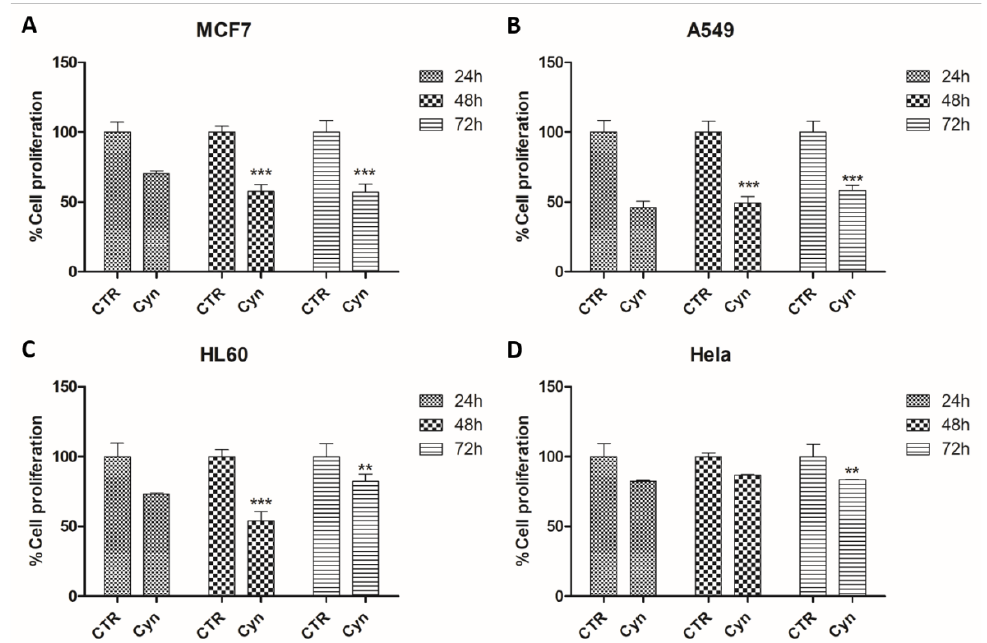
Figure 4. E ff ects of cinnamyl cinnamate treatment on cell proliferation of ( A ) MCF7, ( B ) A549, ( C ) HL60, and ( D ) Hela malignant cells. 500 cells were plated, in triplicate, in 384-well plates and treated with cinnamyl cinnamate at concentration of 10 µ M for 24, 48 and 72 h; cells treated with DMSO were used as control. Cell proliferation was measured performing a cell titer assay and expressed as a percentage of control ( ** p < 0.005; *** p < 0.0005). Each column represents the mean ± SD of three di ff erent wells.